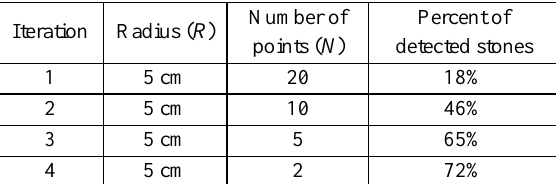
Table 3. Rocks segmentation results for the test sample